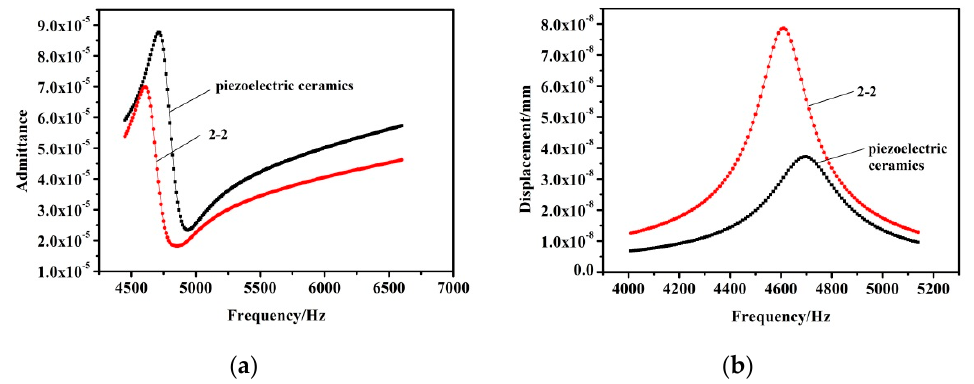
Figure 17. ( a ) Admittance curves of the 2-2 and ceramic vibrators. ( b ) Vibration displacement curves of the 2-2 and ceramic vibrators.